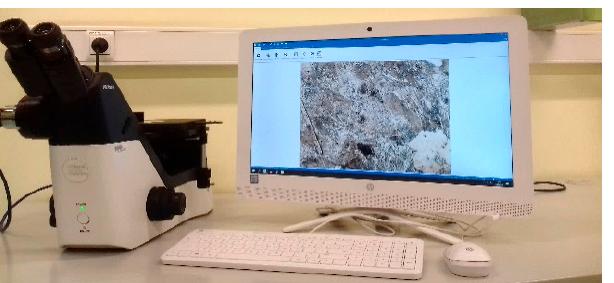
Figure 5. An upgraded Nikon Eclipse MA100N metallographic microscope used for visual obser ‐ vations of the nozzle tip of the GDI system injector under study. tions of the nozzle tip of the GDI system injector under